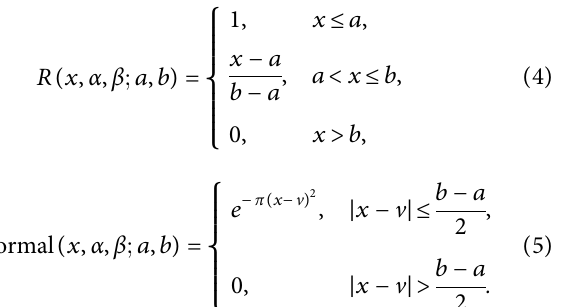
Figure 1: Affiliation function-effect curve of height fuzzy